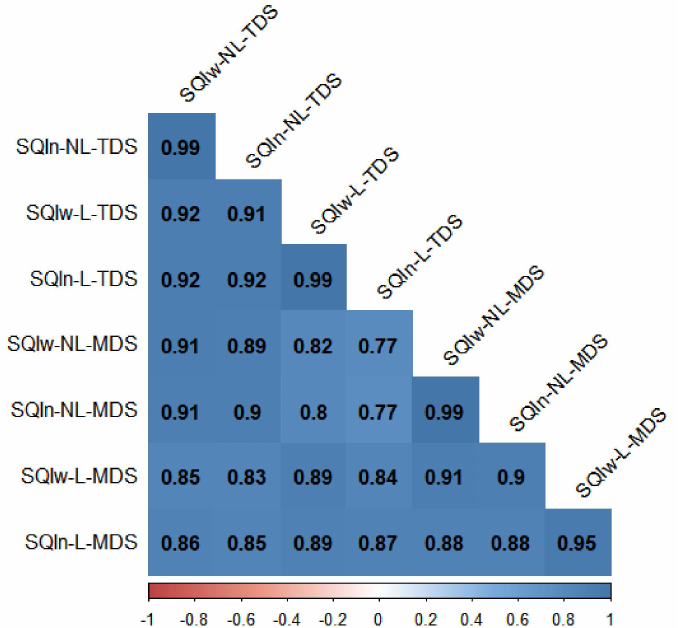
Figure 6. Pearson’s correlation coefficients for different data sets and scoring systems for soil quality indices ( SQIs ) at the 0.01 probability level. ( SQI w —weighted additive soil quality index; SQI n — nemoro soil quality index; MDS—minimum data set; TDS—total data set; L—linear; and NL—non-